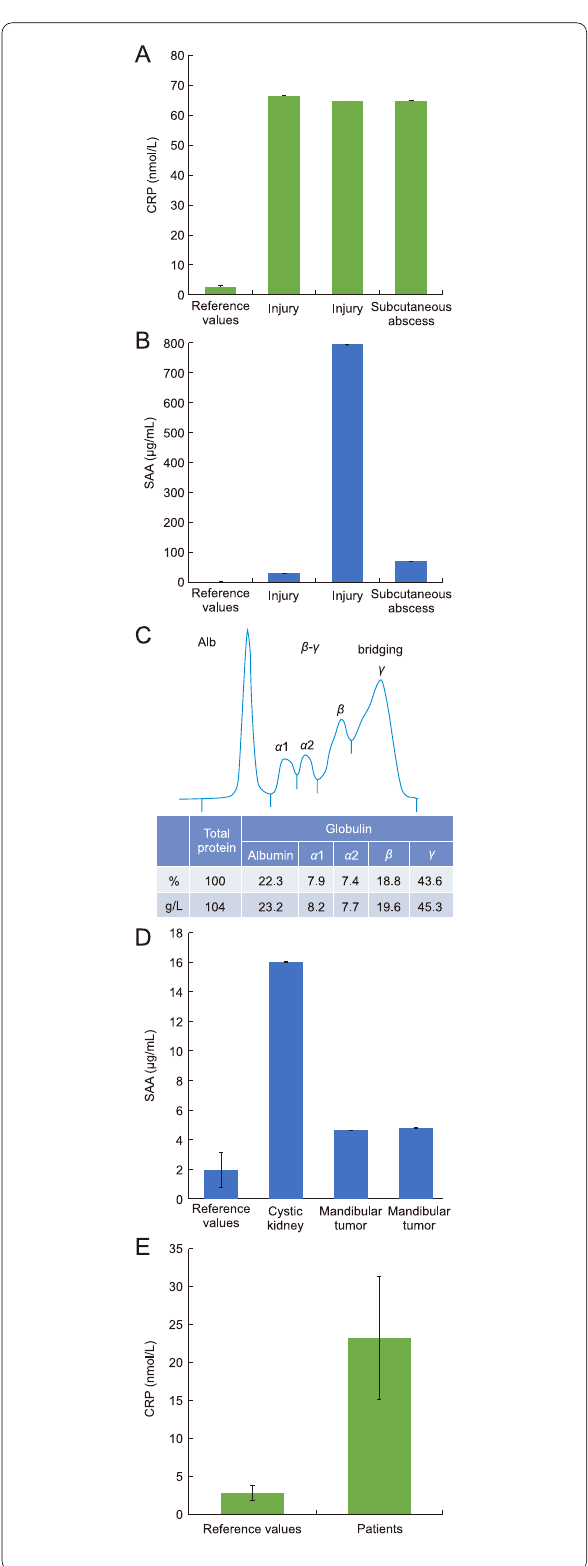
Fig. 3 Acute phase proteins in animal patients. A , B and C Japanese raccoon dogs with injury and subcutaneous abscess. A and B show increased vCRP and vSAA, respectively. The reference value of CRP is 2.85 0.40 nmol/L ( n 4) and 2.20 0.20 μg/mL ( n 4) for ± = ± = SAA. C Serum protein electrophoretic trace exhibits increased α, β- and γ-globulin fractions. D vSAA concentrations obtained from Suncus. The reference value is